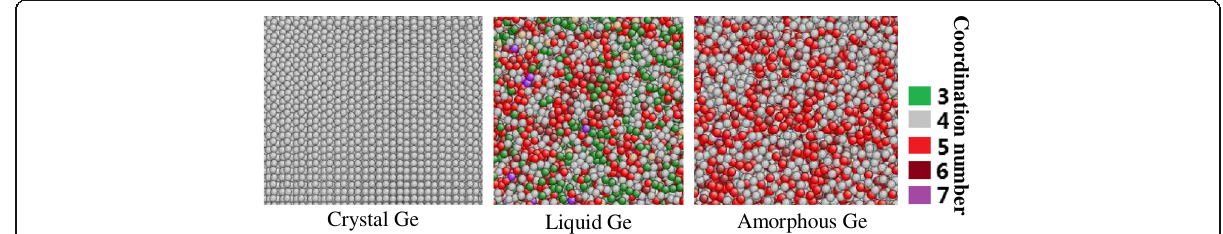
Fig. 3 Coordination number distributions of monocrystalline, liquid, and amorphous germanium